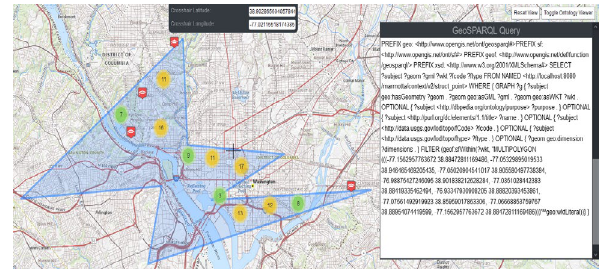
Figure 5 : The project UI showing generated output of a custom GeoSPARQL query from the query builder.